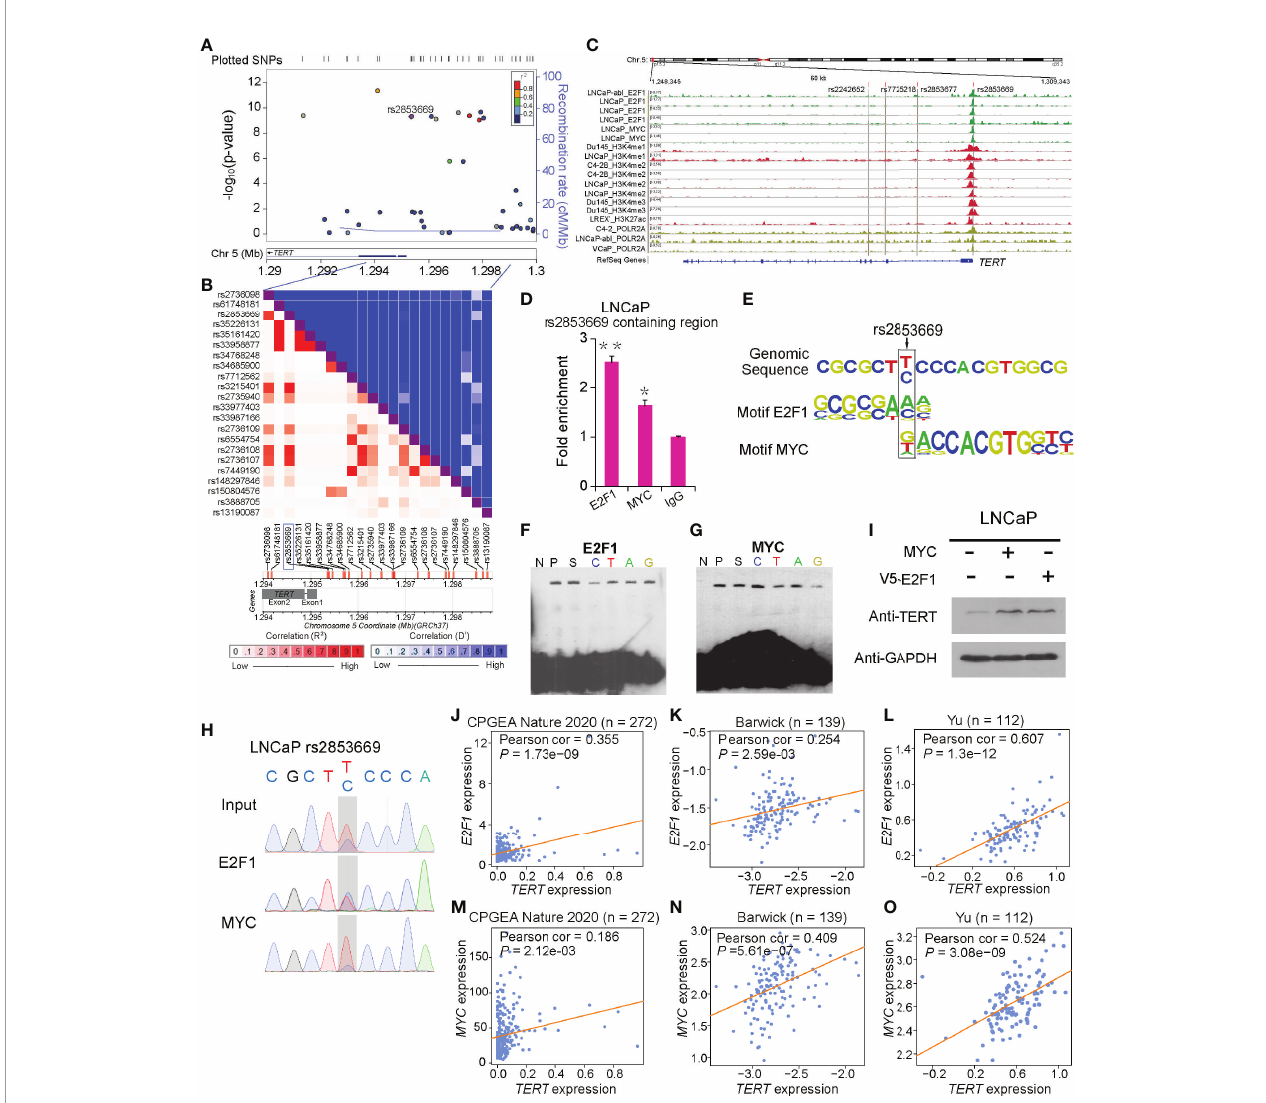
FIGURE 1 | rs2853669 modulated E2F1 and MYC binding to the TERT promoter region. (A) Regional plot of the associated SNPs at chr5:1.29mbp − 1.30mbp. The plot showed the – log 10 p -values of association between the SNPs in this region and PCa. The intensity of red shading indicated the strength of LD ( r 2 ) with the index SNP (rs2853669). (B) LD matrix plot indicated the LD pattern in the 50-kb region around the 5 ’ -UTR region of TERT based on 1000 Genome CEU population. (C) ChIP-seq enrichment signals showing the bindings of E2F1 and MYC at the TERT promoter region. (D) ChIP-qPCR con fi rmation of the chromatin bindings of E2F1 and MYC at the rs2853669-containing region in LNCaP cells over background levels using a nonspeci fi c IgG antibody. (E) rs2853669 resided within the DNA- binding motifs of E2F1 and MYC. E2F1 was predicted to preferentially bind to C allele of rs2853669, while MYC favored T allele of rs2853669. (F, G) The C allele of rs2853669 showed stronger binding af fi nity for E2F1 than the T allele in an electrophoresis mobility shift assay (EMSA) (F) . The T allele of rs2853669 showed stronger binding af fi nity for MYC than the C allele in an EMSA (G) . Lane N represented no protein extract for DNA to bind. The binding of the consensus sequence to E2F1 (F) or MYC (G) (lane P) was competed by a scrambled sequence (lane S) and by sequences containing the C allele (lane C) and T allele (lane T) of rs2853669 or permutations of an A base (lane A) or G base (lane G) at the same chromosomal location as rs2853669. (H) E2F1 or MYC preferred the binding to C allele or T allele at rs2853669 respectively con fi rmed by ChIP followed by Sanger sequencing in LNCaP cells. (I) Overexpression of MYC or E2F1 in LNCaP cells elevated the protein level of TERT by Western blot. (J – O) Scatterplots showing a positive expression correlation between TERT and E2F1 (J) or MYC (K) in prostate tumor tissues. Error bars, s.e.m. n = 3 technical replicates. * p < 0.05, ** p < 0.01. The p- values were assessed using two-tailed Student ’ s t